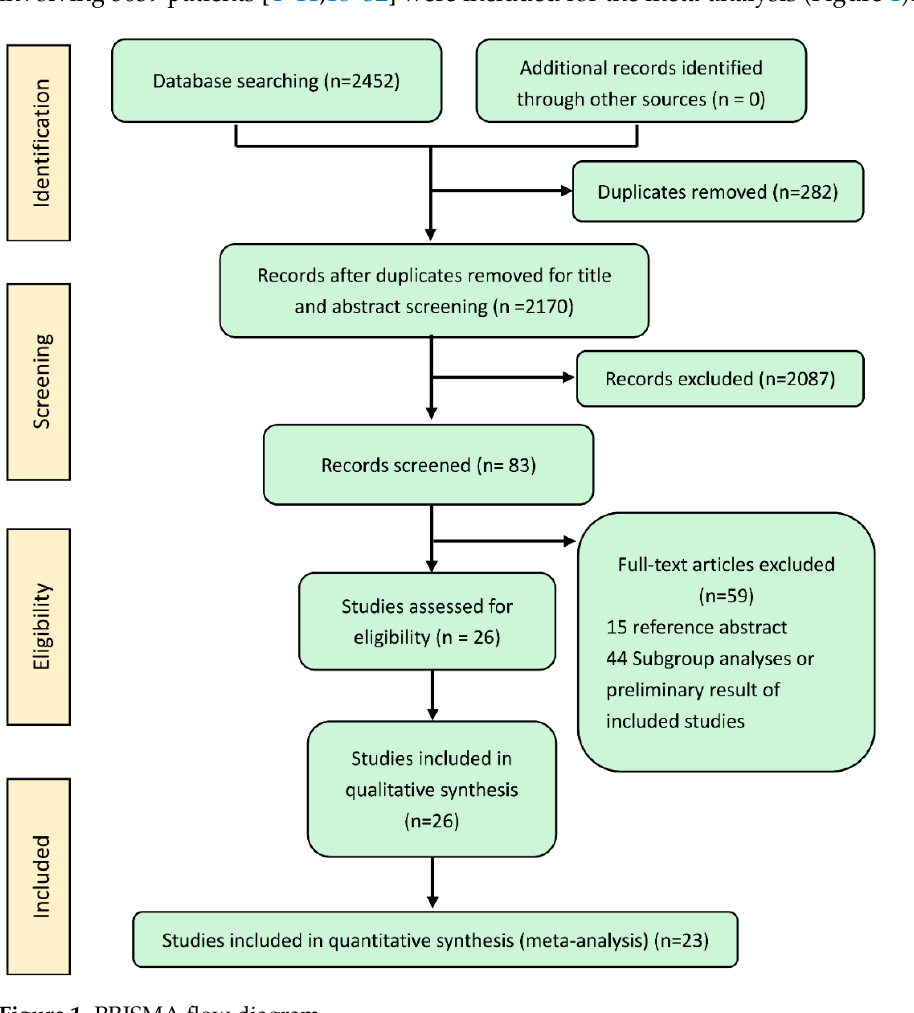
Figure 1. PRISMA flow diagram.